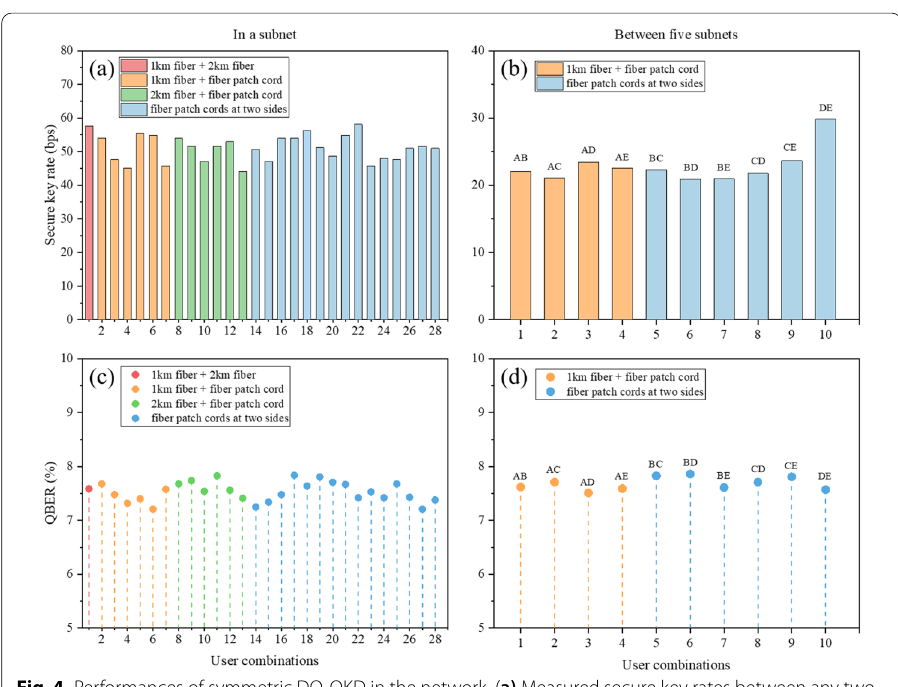
Fig. 4 Performances of symmetric DO-QKD in the network. ( a) Measured secure key rates between any two users in subnet A; 28 links are labeled by numbers on x-axis. Link 1 has transmission fibers of 1 and 2 km at two sides, separately. Links 2–7 only have transmission fibers of 1 km at one side, and links 8–13 only have transmission fibers of 2 km at one side. Links 14–28 do not have these transmission fibers. ( b ) Measured secure key rates between users in different subnets. There are ten links among the five users in five different subnets. The letters on the top of each result indicate two subnets of the two users in the link. All the links with the user from subnet A (1–4) have transmission fibers of 1 km at one side. Other links (5–10) do not have transmission fibers. ( c ) Corresponding QBERs between the users in the subnet A. ( d ) Corresponding